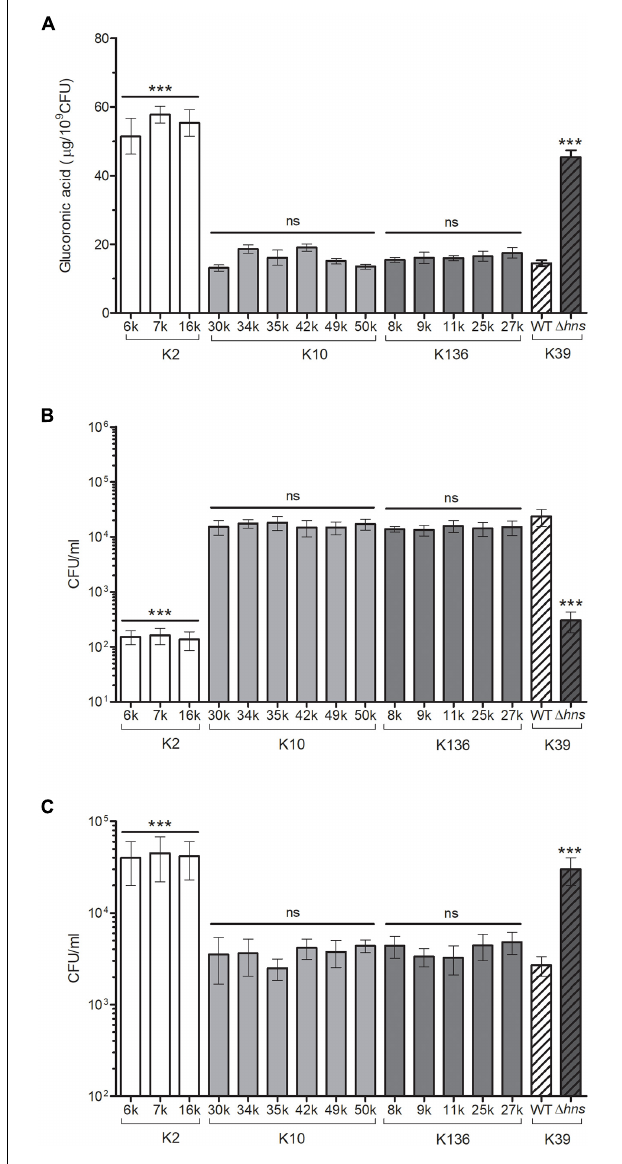
FIGURE 3 | K2 serotype K. pneumoniae is highly resistant to phagocytosis and polymyxin B. (A) Capsule quantification by determination of the glucuronic acid concentration from capsular polysaccharides extracted from 0.5 ml bacterial cultures. (B) Comparison of phagocytic uptake of K. pneumoniae grown under the indicated different conditions by THP-1 macrophages. (C) Polymyxin B activity (4 mg/ml) against K. pneumoniae strains. An (cid:49) hns mutant was evaluated as control of phagocytosis and polymyxin B. ns, not significant; statistically significant with respect to bacteria grown in LB medium: *** p <